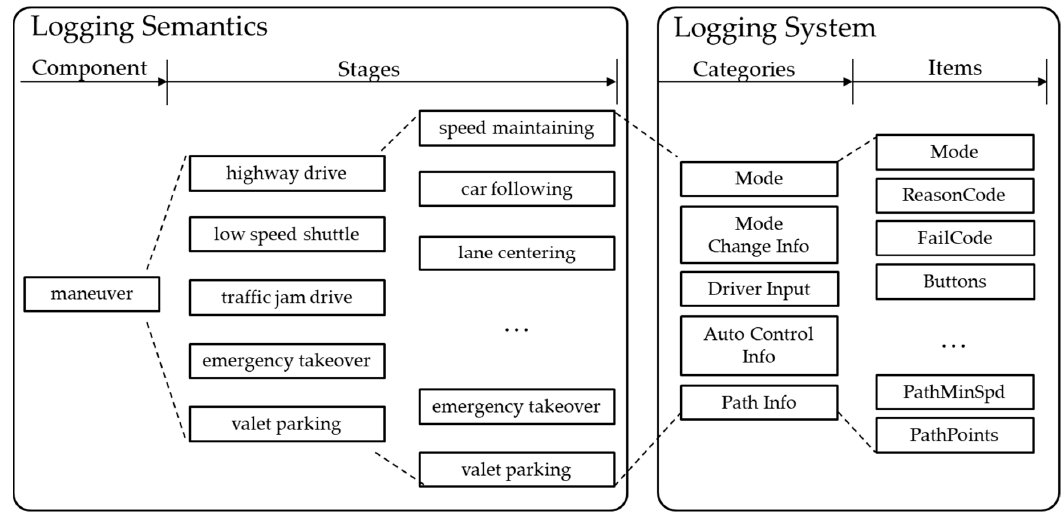
Figure 4. Maneuver component and logging items.